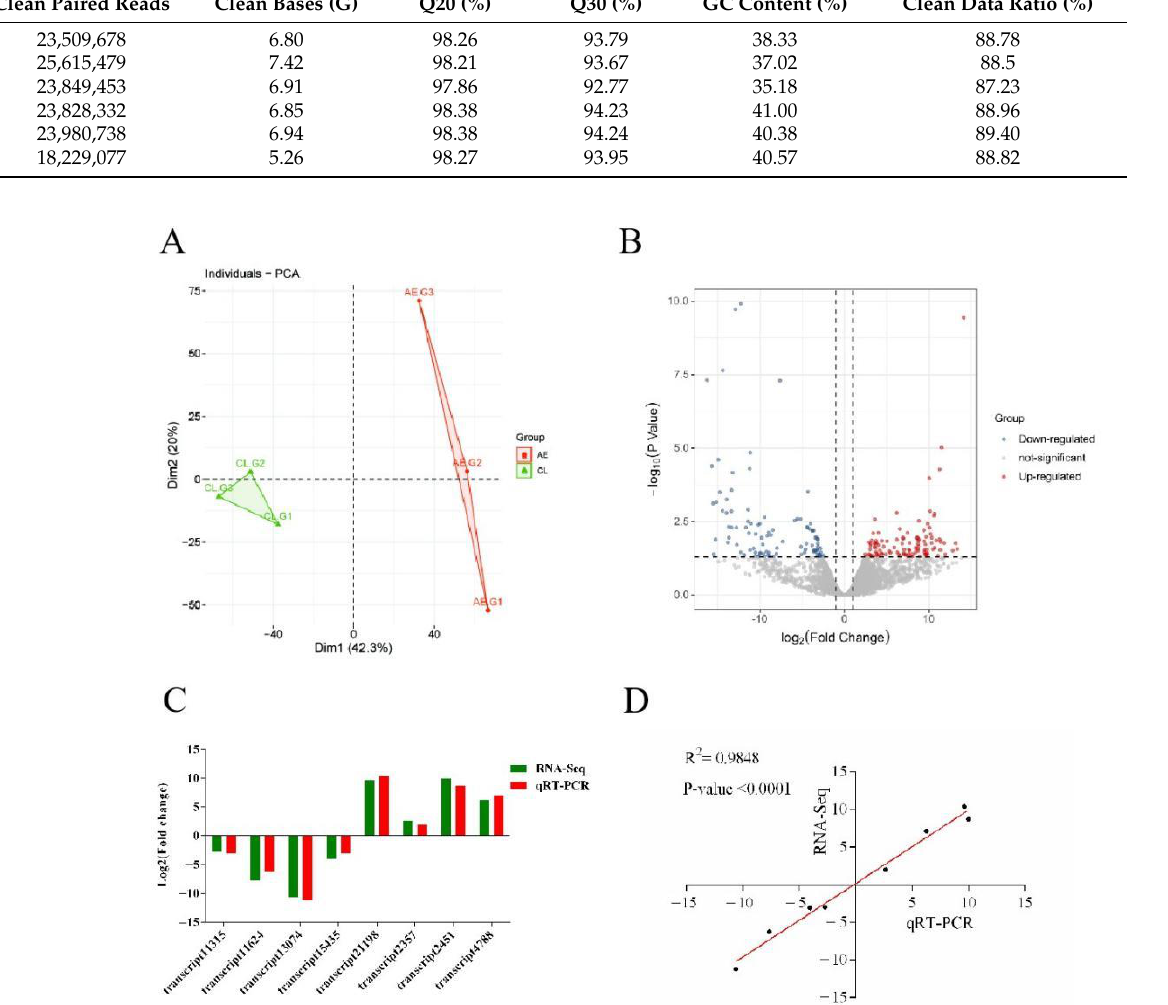
Figure 3. Identification and verification of DEGs. ( A ) The principal component analysis (PCA) of transcript expression in the control group (CL) and air exposure group (AE). ( B ) Volcano map of DEGs. ( C ) Comparison of the RNA-Seq and qRT-PCR results. ( D ) Correlation of gene expression results respectively obtained by RNA-Seq and qRT-PCR.